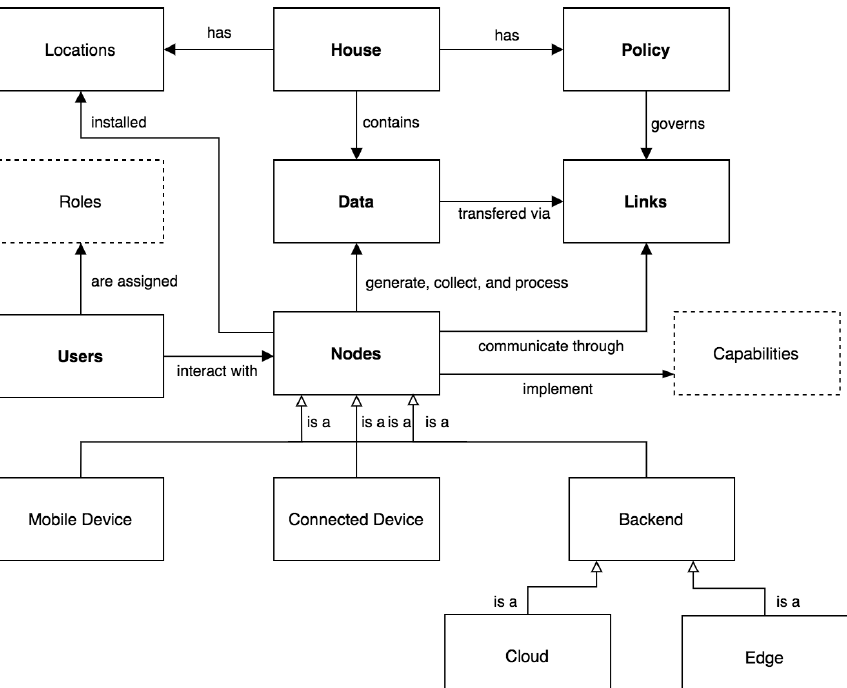
Figure 3. A schematic illustration of the smart home model’s components, including the logical relationships between them. Items indicated in bold represent the main attributes of the system model. Dotted boxes indicate abstract